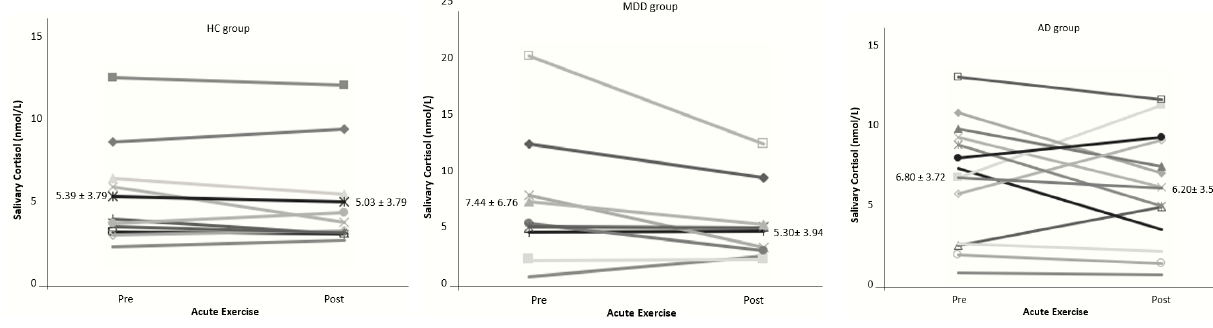
C) Figure 1: Effect of acute stressor (physical exercise) in cortisol levels in older individuals; Healthy Control (HC) group (A); Major Depressive Disorder (MDD) group (B); Alzheimer Disease (AD) group (C); Data in mean ± standard